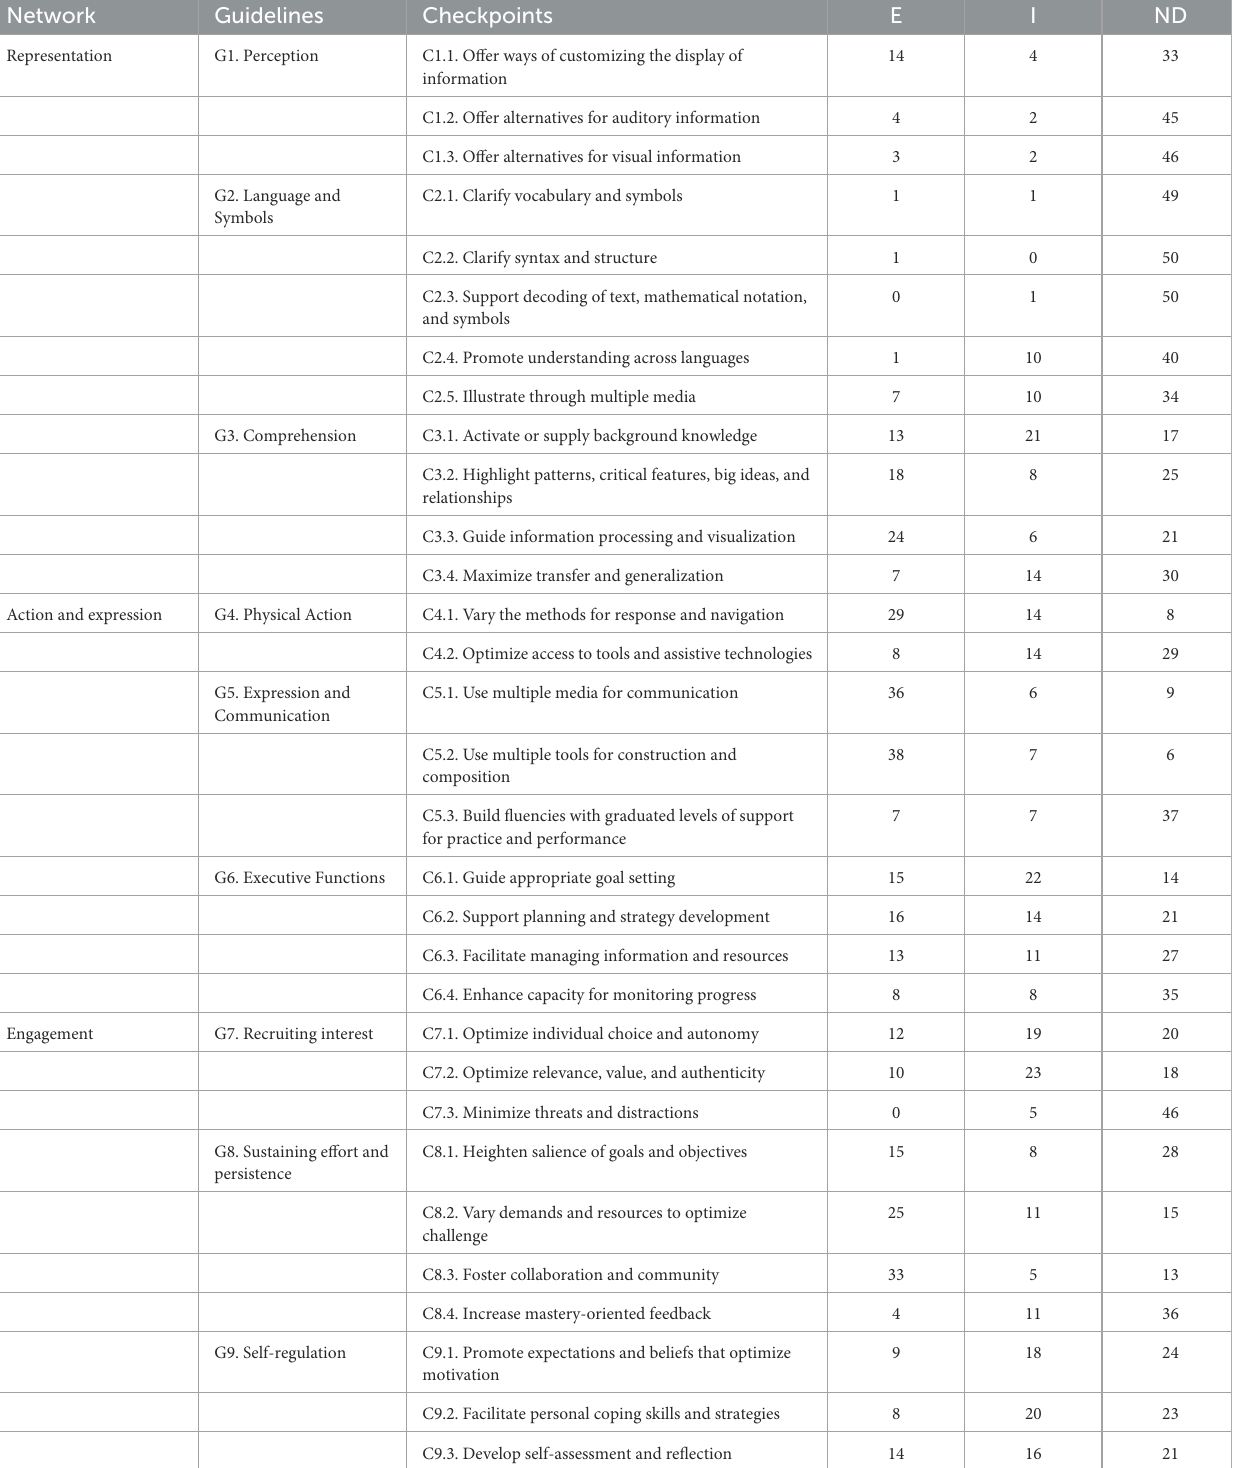
TABLE 4 Networks, guidelines, and checkpoints collected during the screening process of the systematic review according to explicit (E), implicit (I), and not developed (ND).